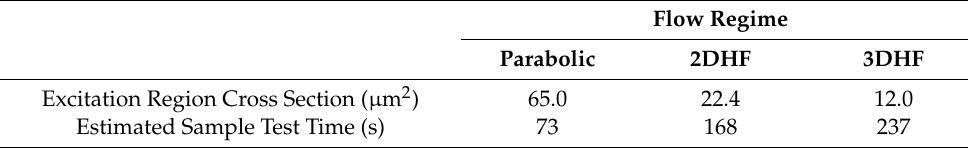
Table 2. Excitation region cross sectional area and test time for each design